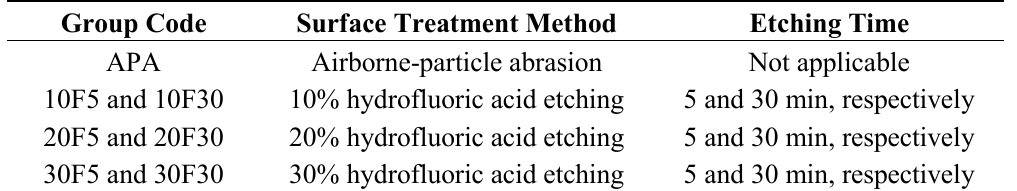
Table 1. Experimental specimen groups and their different surface